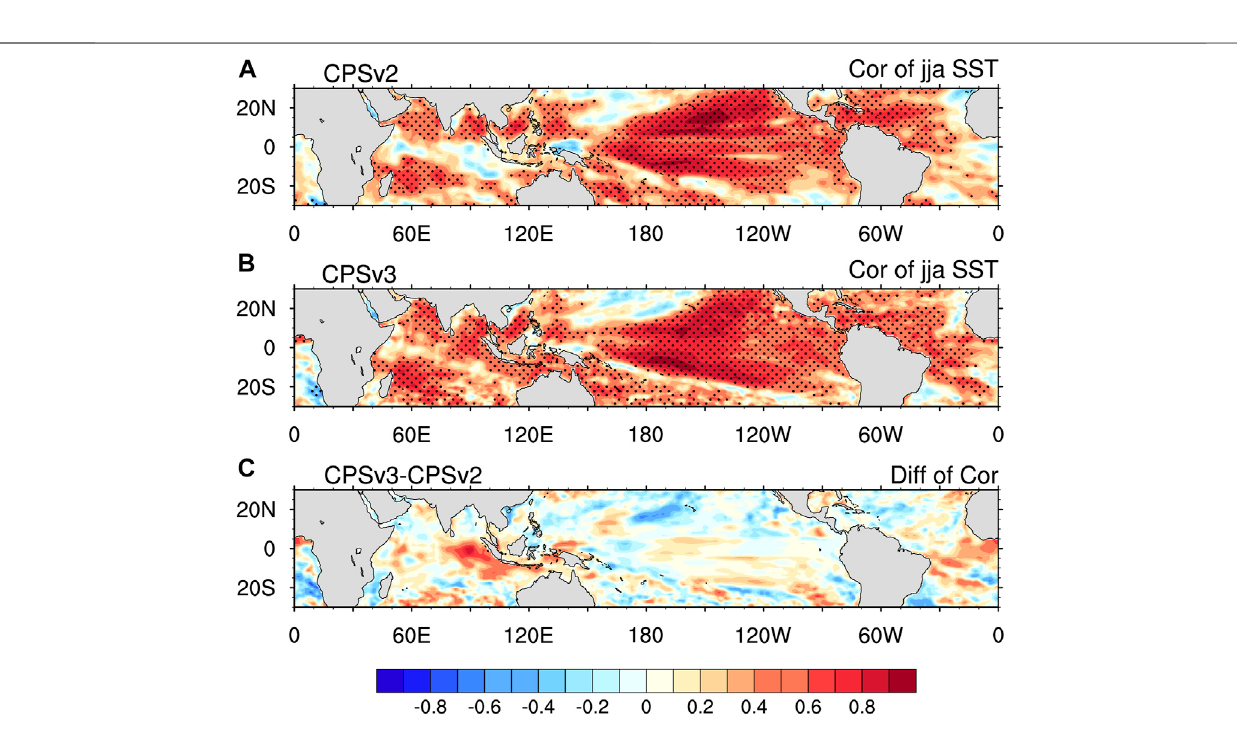
Frontiers in Earth Science |